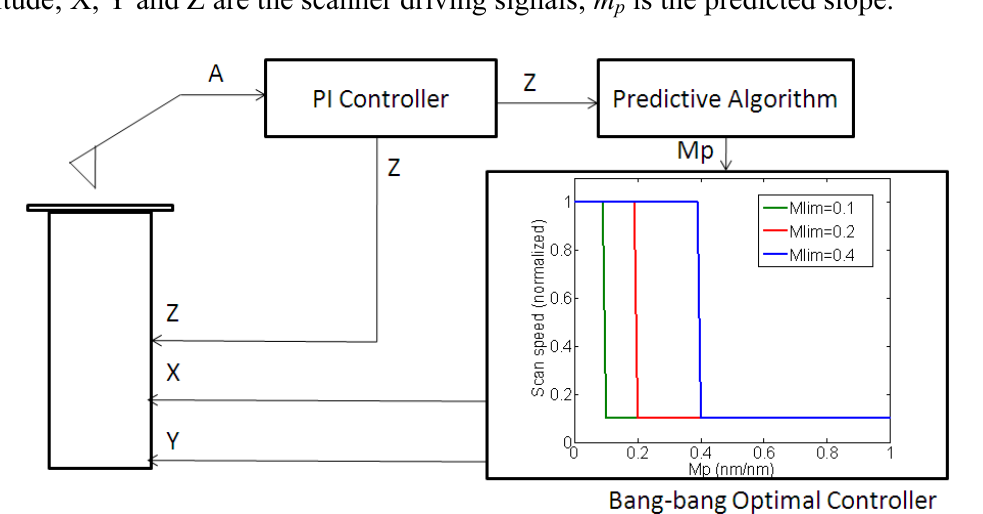
Figure 4. Bang-bang optimal control implementation. A is the cantilever oscillation amplitude; X, Y and Z are the scanner driving signals; m